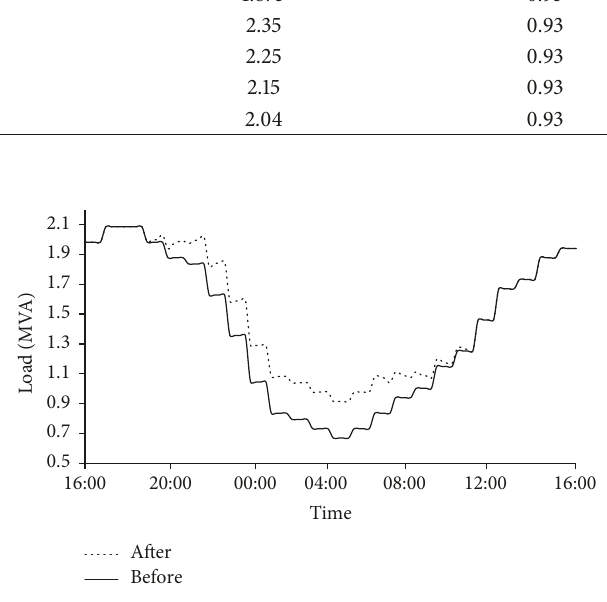
Figure 5: Load profile before and after CS